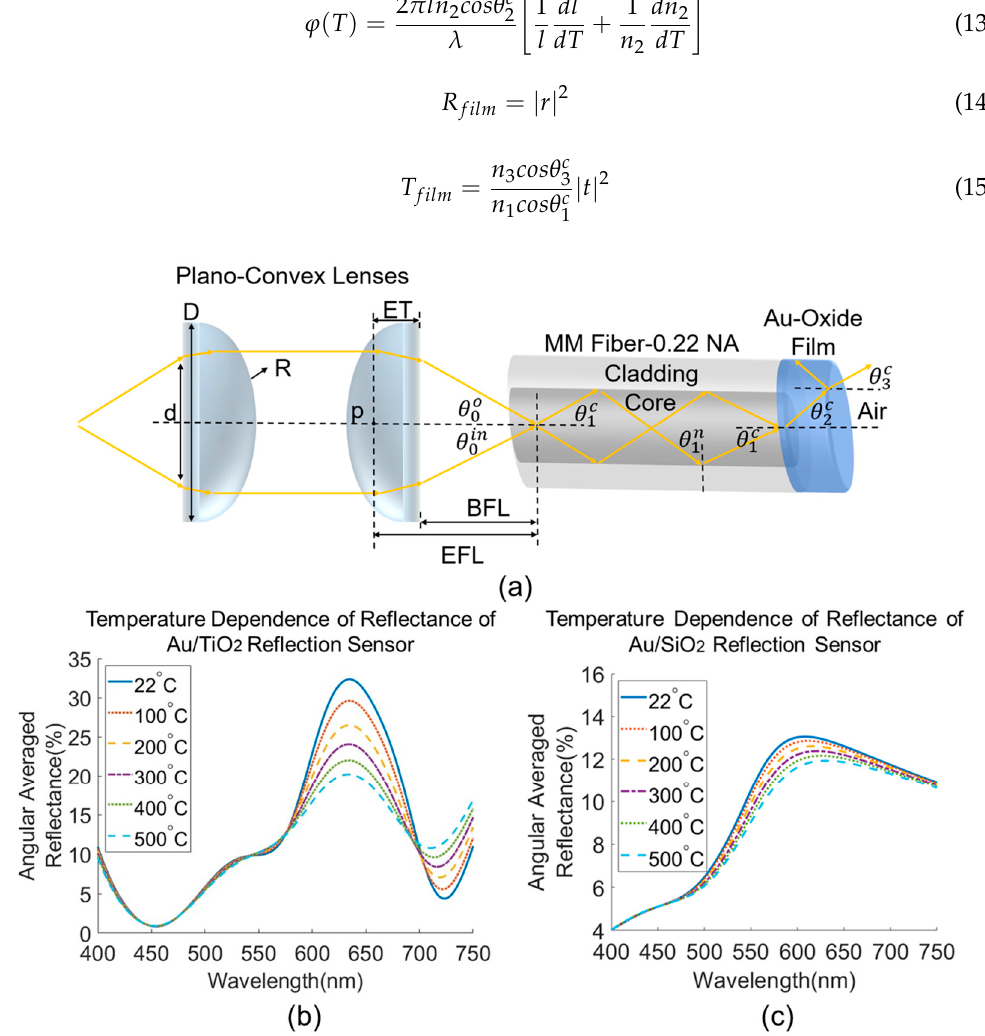
Figure 9. ( a ) Graphical illustration of optical waveguide model of Au/Oxide nanocomposite-coated sensor in reflection geometry, assuming free space coupling of plano-convex lenses. Simulated temperature dependence of the absolute reflectance averaged at a range of incident angles for ( b ) Au/TiO 2 sensor and ( c ) Au/SiO 2 sensor.